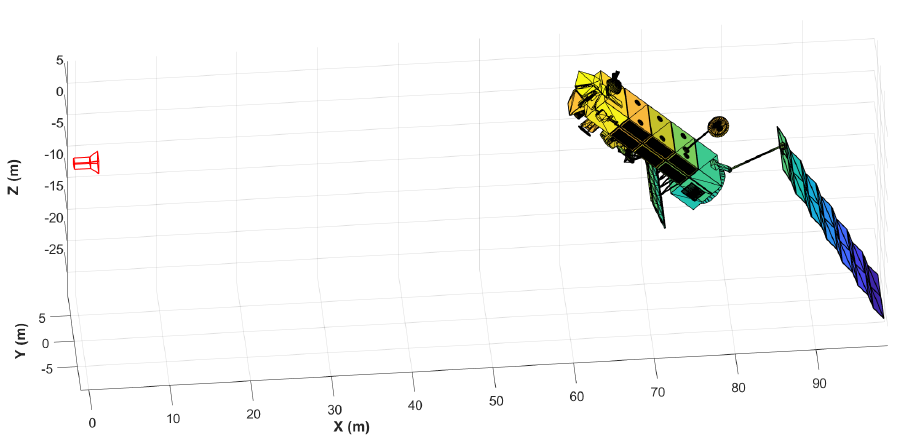
Figure 7. Positioning of the LiDAR (red) and the Satellite.